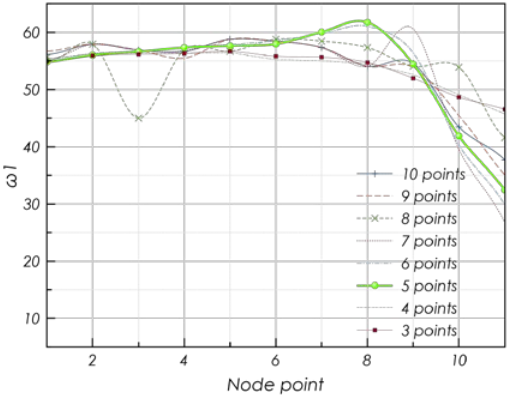
Fig. 4. Graph of the change of the angle ω1 along the cutting edge in the section of the gash